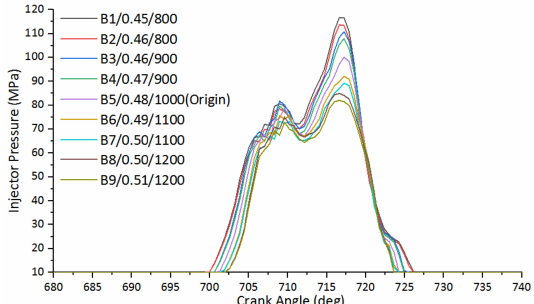
Figure 27. Fuel injection pressure for Pre-selection schemes.